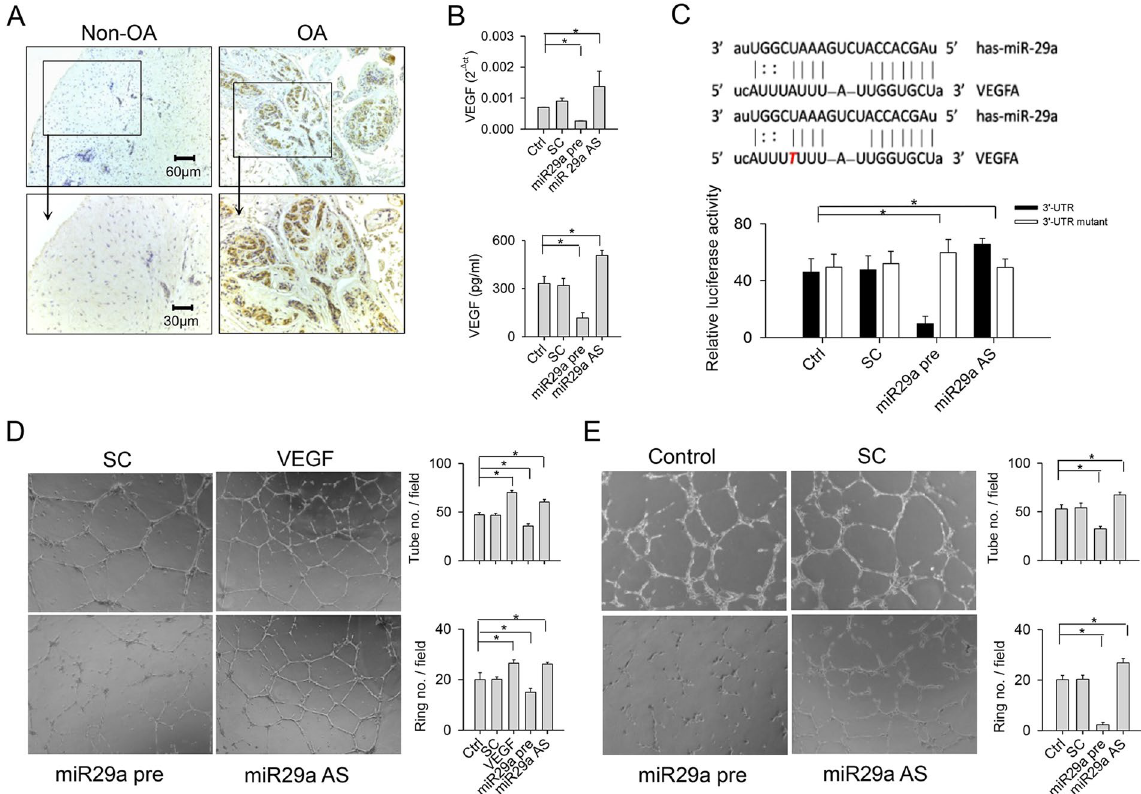
Figure 7. Analyses of miR-29a action to VEGF expression in synovial fibroblasts. ( A ) Synovial cells expressed strong VEGF immunostaining in synovial specimens from patients with end-stage OA knees. ( B ) miR-29a transfection reduced VEGF mRNA expression of synoival fibroblasts and VEGF levels in culture supernatants. miR-29a antisense oligonucleotide transfection increased VEGF expression. ( C ) The sequence of miR-29a binding to the intact and mutated 3 ′ -UTR of VEGF. miR-29a precursor reduced the VEGF 3 ′ -UTR luciferase reporter activity. miR-29a antisense oligonucleotide increased luminescence reaction. ( D ) HUVECs exposed to culture supernatants from the miR-29a-transfected synovial fibroblasts reduced tube and vessel ring formation. ( E ) HUVECs transfected with miR-29a showed low angiogenesis. Each bar plot stands for mean ± standard error calculated from at least 4 times in each group and analyzed by a parametric analysis of variance (ANOVA) and a Bonferroni post-hoc test. Asterisks ( * ) stands for significant difference between